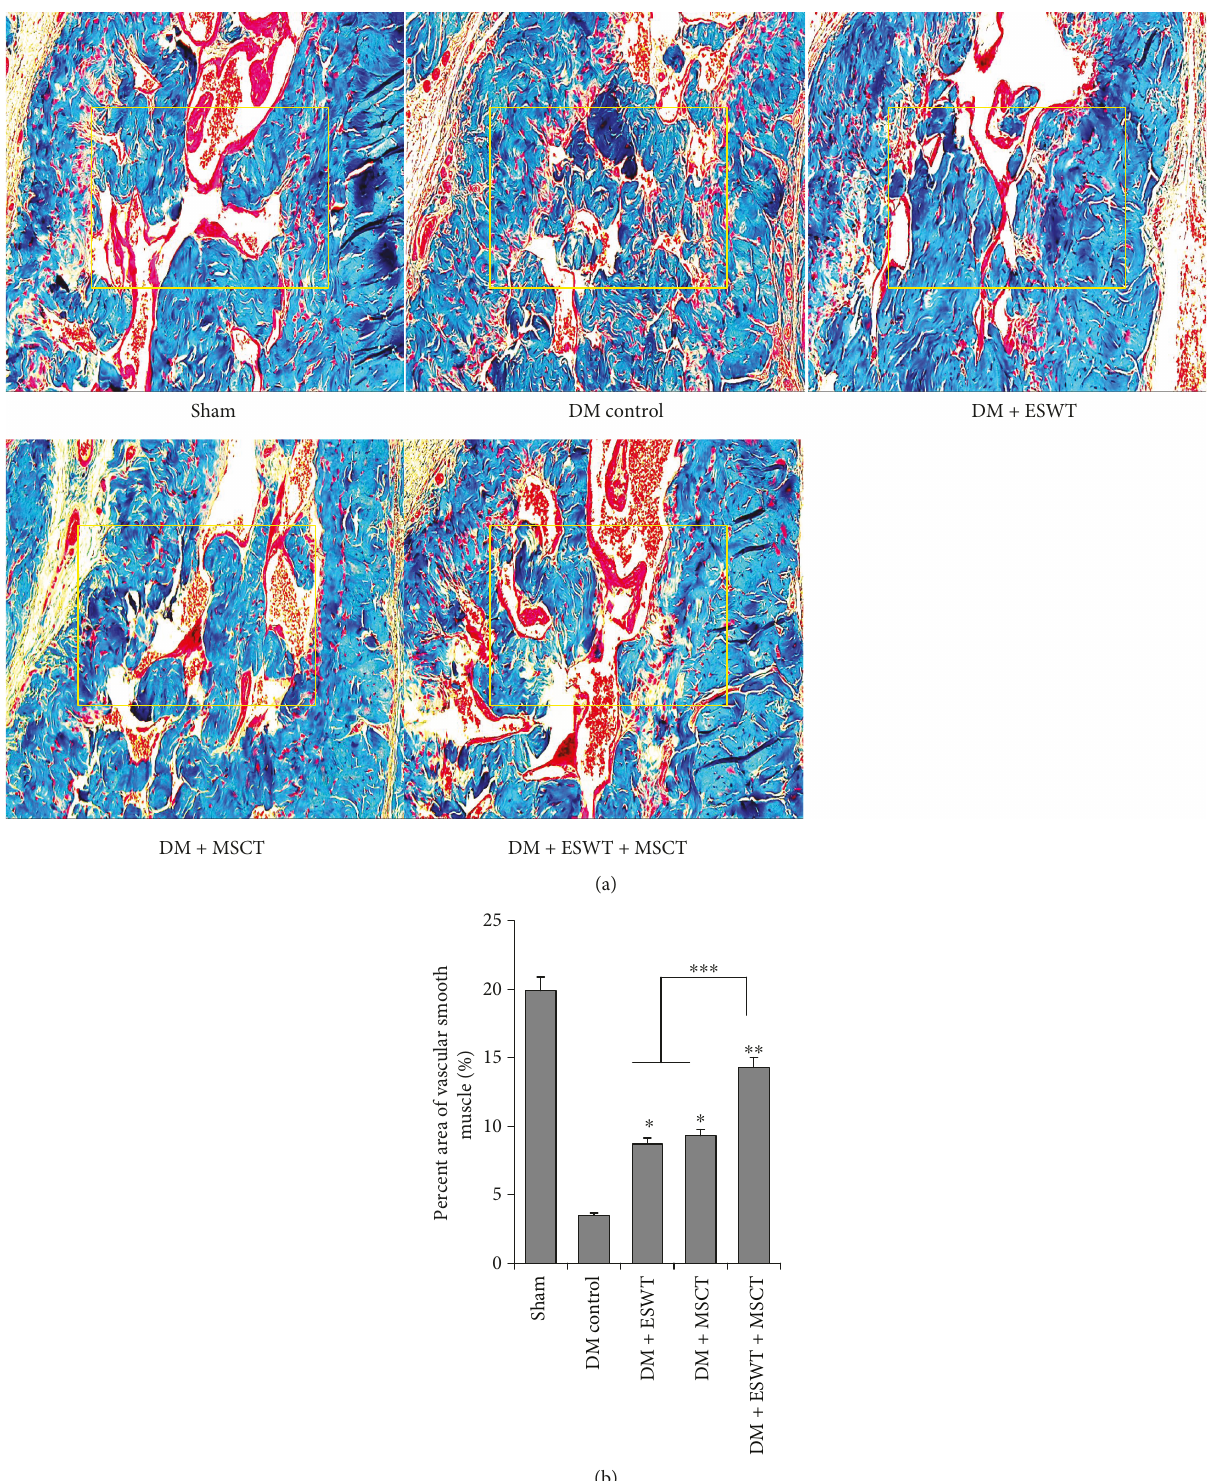
Figure 2: Masson staining of corpus cavernosum (a) Representative images of Masson trichrome stain for each group. Red is vascular smooth muscle, and blue is collagen. Original magni fi cation: × 200. (b) Percentage area of endothelial cell smooth muscle cells for each group. Each bar shows the mean values (standard deviation). ∗ P < 0 05 compared with the DM control group. ∗∗ P < 0 01 compared with the DM control group. ∗∗∗ P < 0 05 compared with the DM+ ESWT and DM+ MSCT